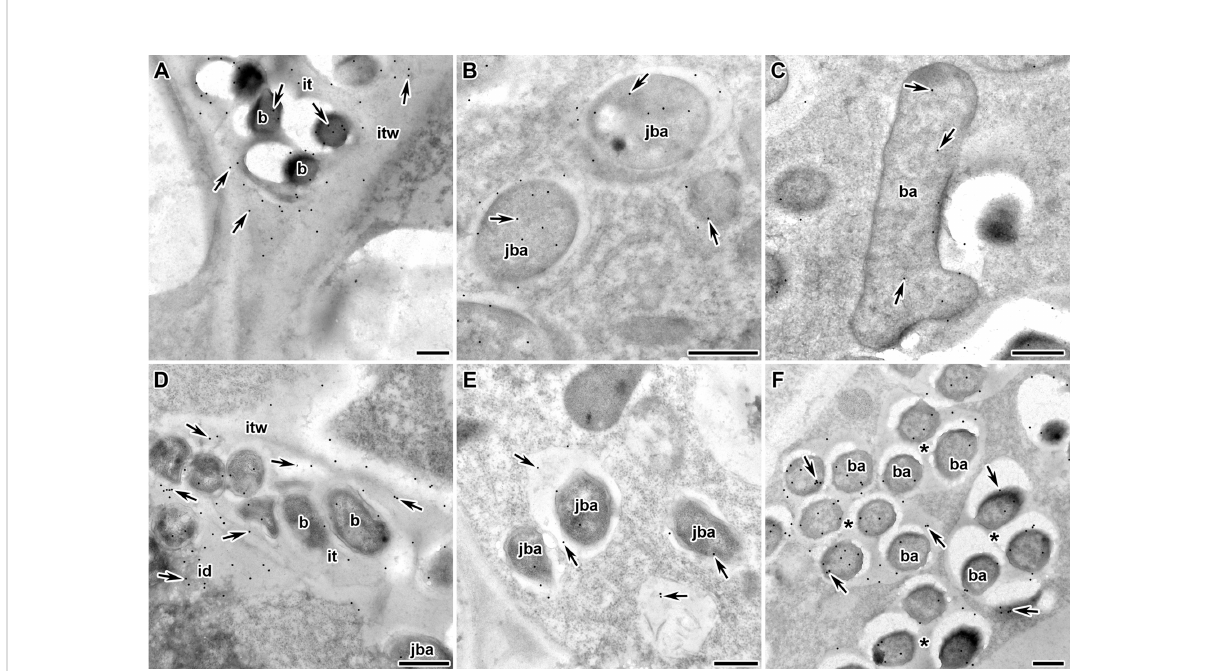
FIGURE 3 Immunogold localization of RopB protein in the nodules of P. sativum L. in wild-type line Sprint-2Fix + (A – C) and mutant line Sprint-2Fix - ( sym31 ) (D – F) . The RopB label is in the infection thread (A, D) , juvenile symbiosomes (B, E) , mature symbiosomes (C) and multibacteroid symbiosomes characteristics for mutant line Sprint-2Fix - ( sym31 ) (F) . it – infection thread, itw – infection thread wall, id – infection droplet, b – bacteria, ba – bacteroid, jba – juvenile bacteroid, * – multibacteroid symbiosome, arrows indicate gold particles. Scale bars are equal to 500 nm. For negative control see Supplementary Figure